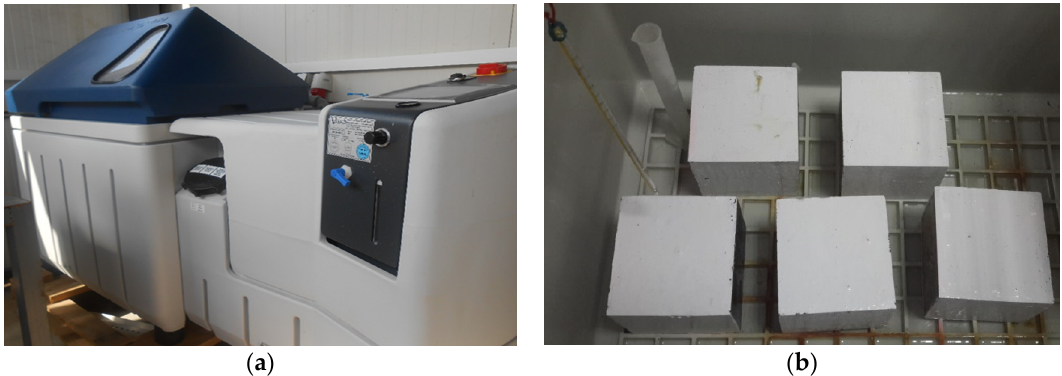
Figure 2. ( a ) Salt spray chamber and ( b ) sealed specimens inside the chamber.